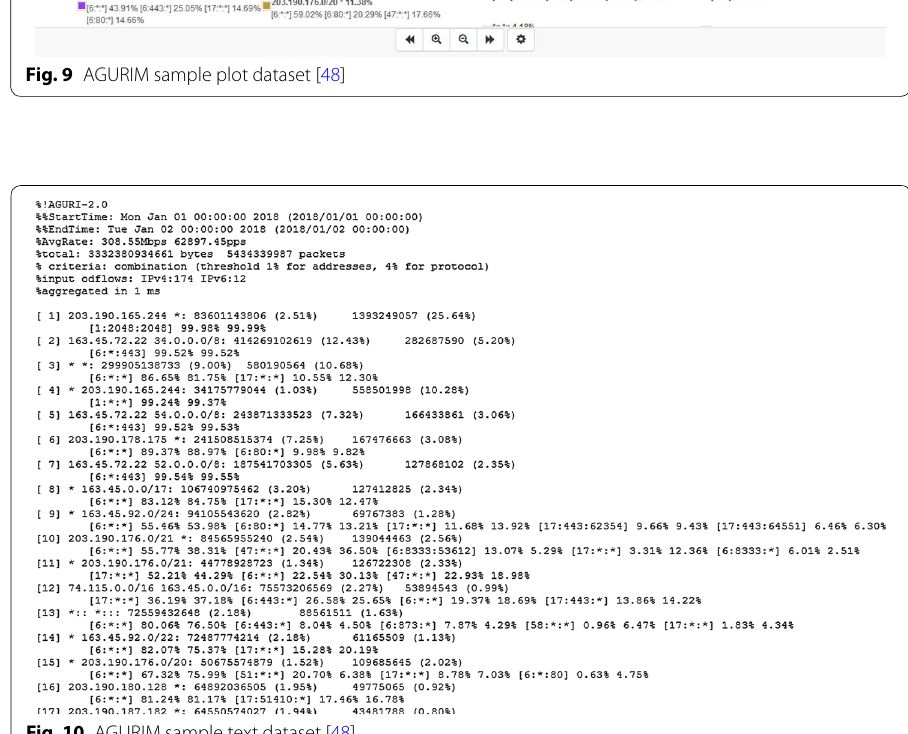
Fig. 10 AGURIM sample text dataset